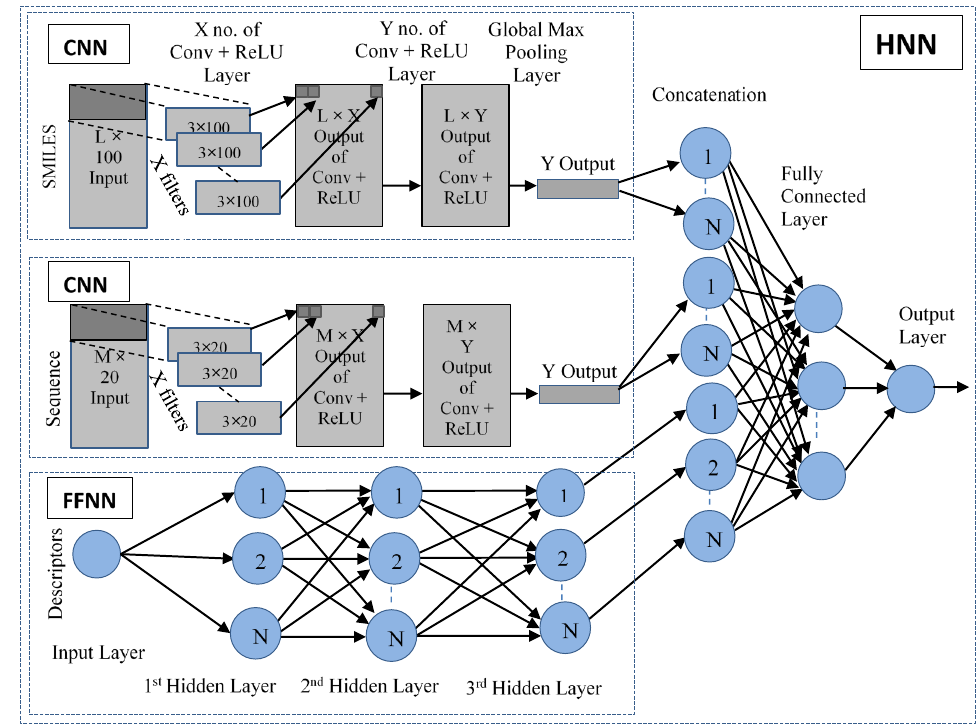
Figure 2. The deep learning-based hybrid neural network (HNN) model framework.